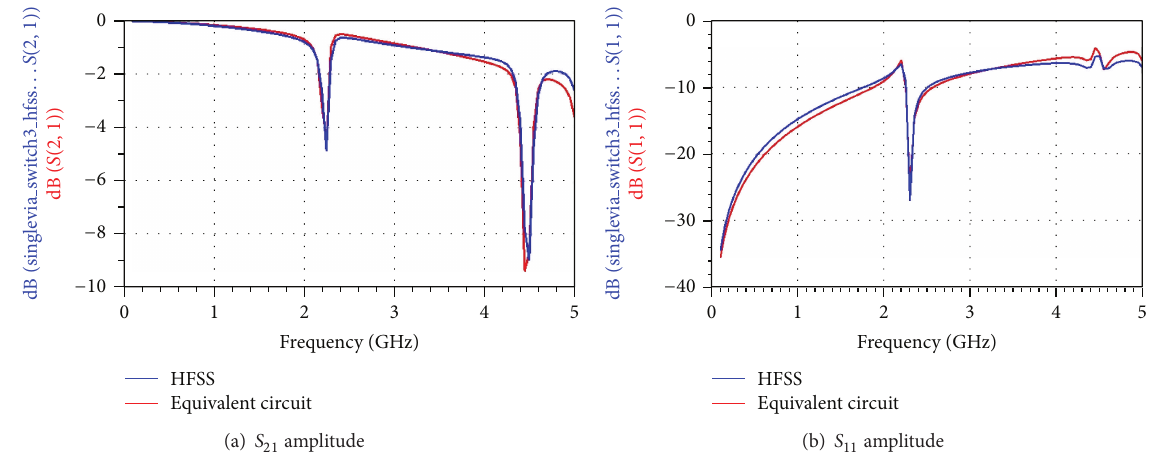
Figure 28: Simulation results of switching